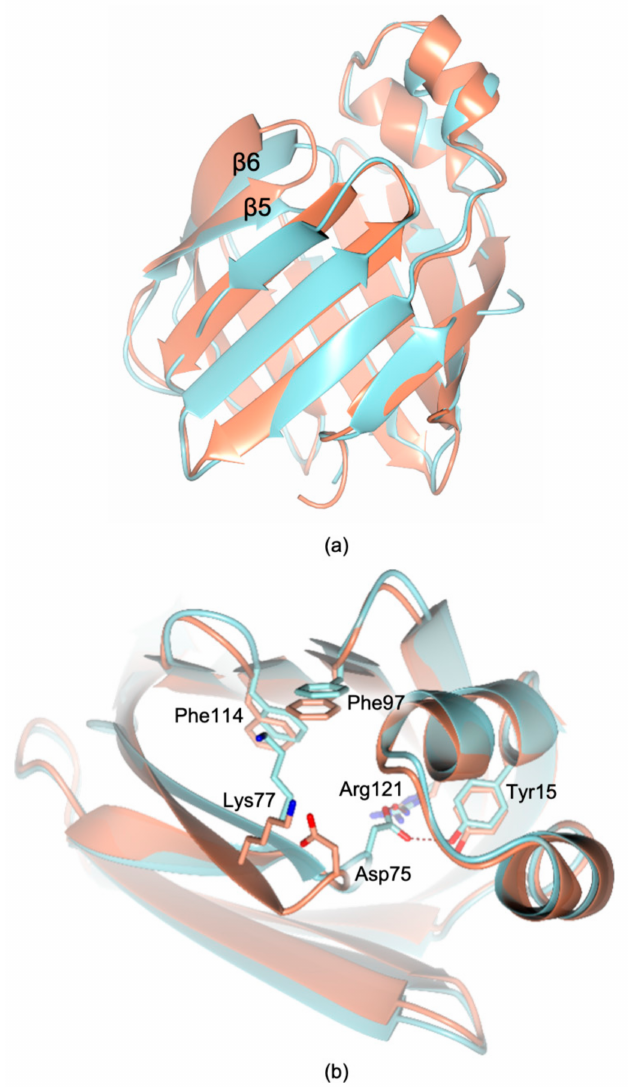
Figure 5. ( a ) Comparison between the structural models of recombinant cL-BABP (coral cartoon) and the chicken liver extracted protein (cyan cartoon; PDB code 1TVQ [18]). Meaningful changes are observed in the loop connecting the strands β 5 and β 6, where the maximum displacement is reported upon C α matching. ( b ) View of the ligand cavity in the superimposition between the structural models of recombinant cL-BABP (coral cartoon and carbons) and the chicken liver extracted protein (cyan cartoon and carbons; PDB code 1TVQ [18]). In all figures, hydrogen bonds are displayed as tan dashed lines; oxygen and nitrogen atoms are colored red and blue,